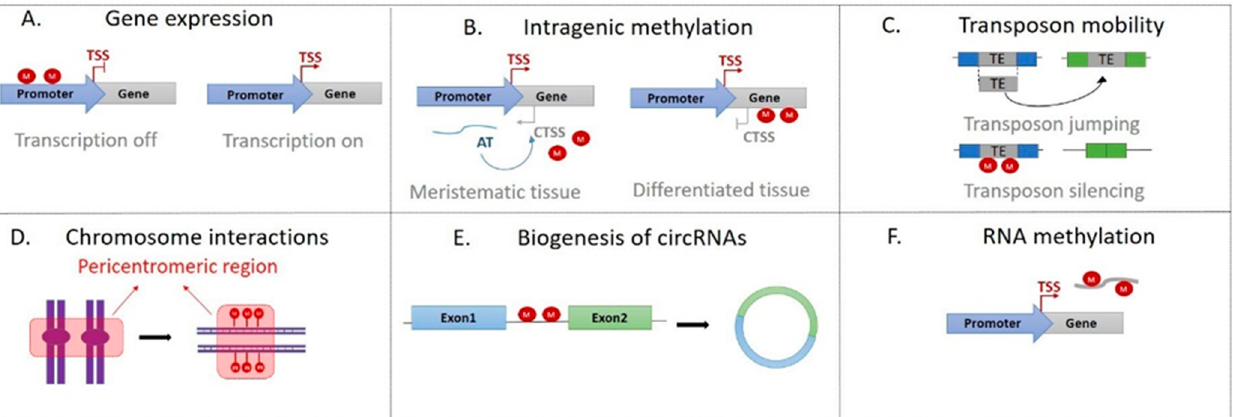
Figure 2. Different roles of DNA methylation in plant cells. ( A ) The promoter DNA methylation (red circle) represses transcription activity and gene expression; ( B ) methylation of the coding regions generates an inaccessible chromatin structure suppressing the aberrant transcription start site; ( C ) DNA methylation affects genome stability by silencing transposons and other DNA repeated sequences; ( D ) chromosome interactions through pericentromeric regions or heterochromatin islands depend on the methylation of these regions; ( E ) DNA methylation could be involved in the biogenesis of circRNAs; ( F ) mRNA methylation controls stability, splicing, and processing of the transcript itself. TSS, transcription start site; CTSS, cryptic transcription start site; AT, aberrant transcript; TE, transposable elements.